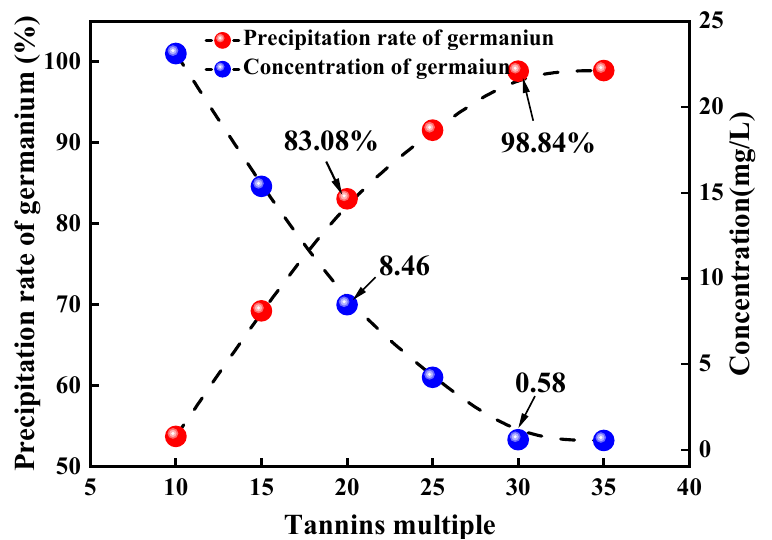
Figure 2. Germanium complex rate and germanium concentration at di ff erent tannin multiples. From Figure 2, with the increase of the tannin multiples, the germanium concentration in the solution after germanium complex is continuously decreasing and steadied at 0.58 mg/L, while the corresponding germanium complex rate is gradually increasing from the initial rapid increase by up to 98.84%. When the amount of tannins used is 20 multiples, the germanium concentration at this multiple is 8.46 mg/L, and the germanium complex rate reaches 83.08%, which proves that the reaction ability of germanium and tannins is strong. After the continuous increase in the amount of tannins used, the growth trend slows down. When the amount of tannins is 30 multiples, the concentration of germanium after germanium complex is 0.58 mg/L, and the germanium complex rate reaches 98.84%, which further shows that germanium and tannins has a strong reaction ability. Then, it has a tendency to be fl at, indicating that the germanium deposition rate has reached an in fl ection point at this point. When the tannic acid dosage reaches 35 times, the germanium concentration in the germanium precipitation solution